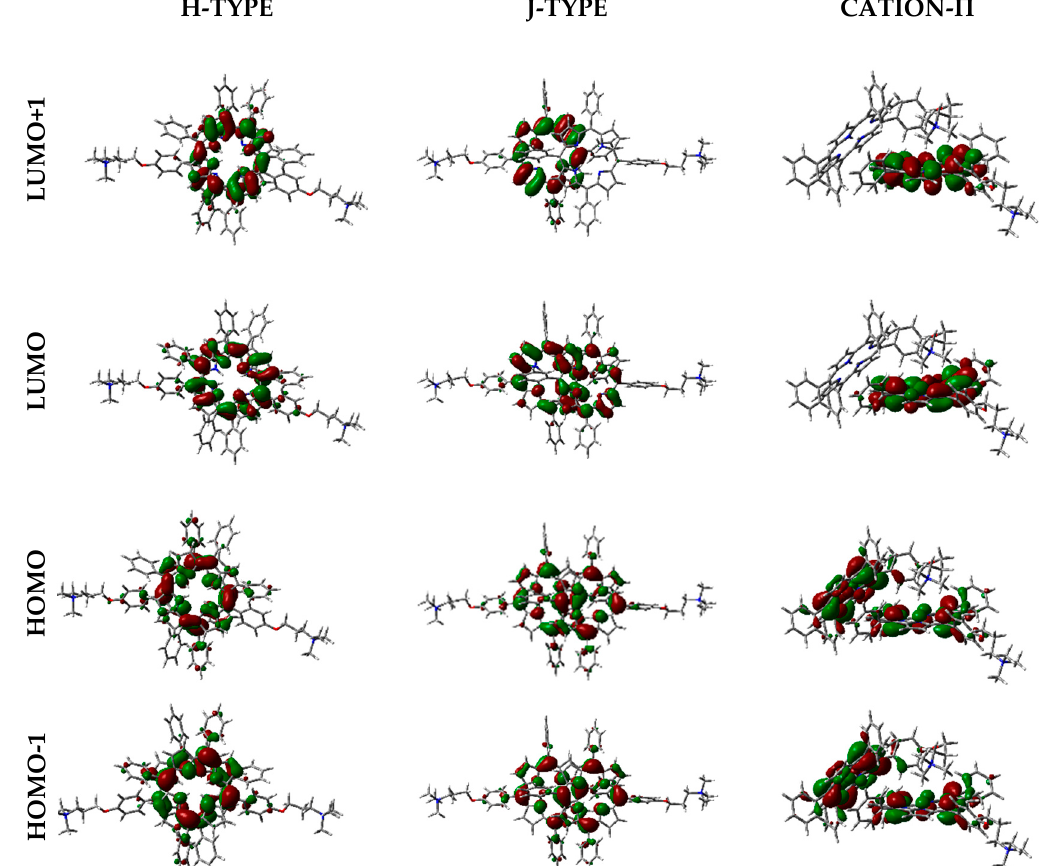
Figure 12. Frontier orbitals representation in the vacuum, calculated with WB97XD functional and 6-31G(d) basis set.